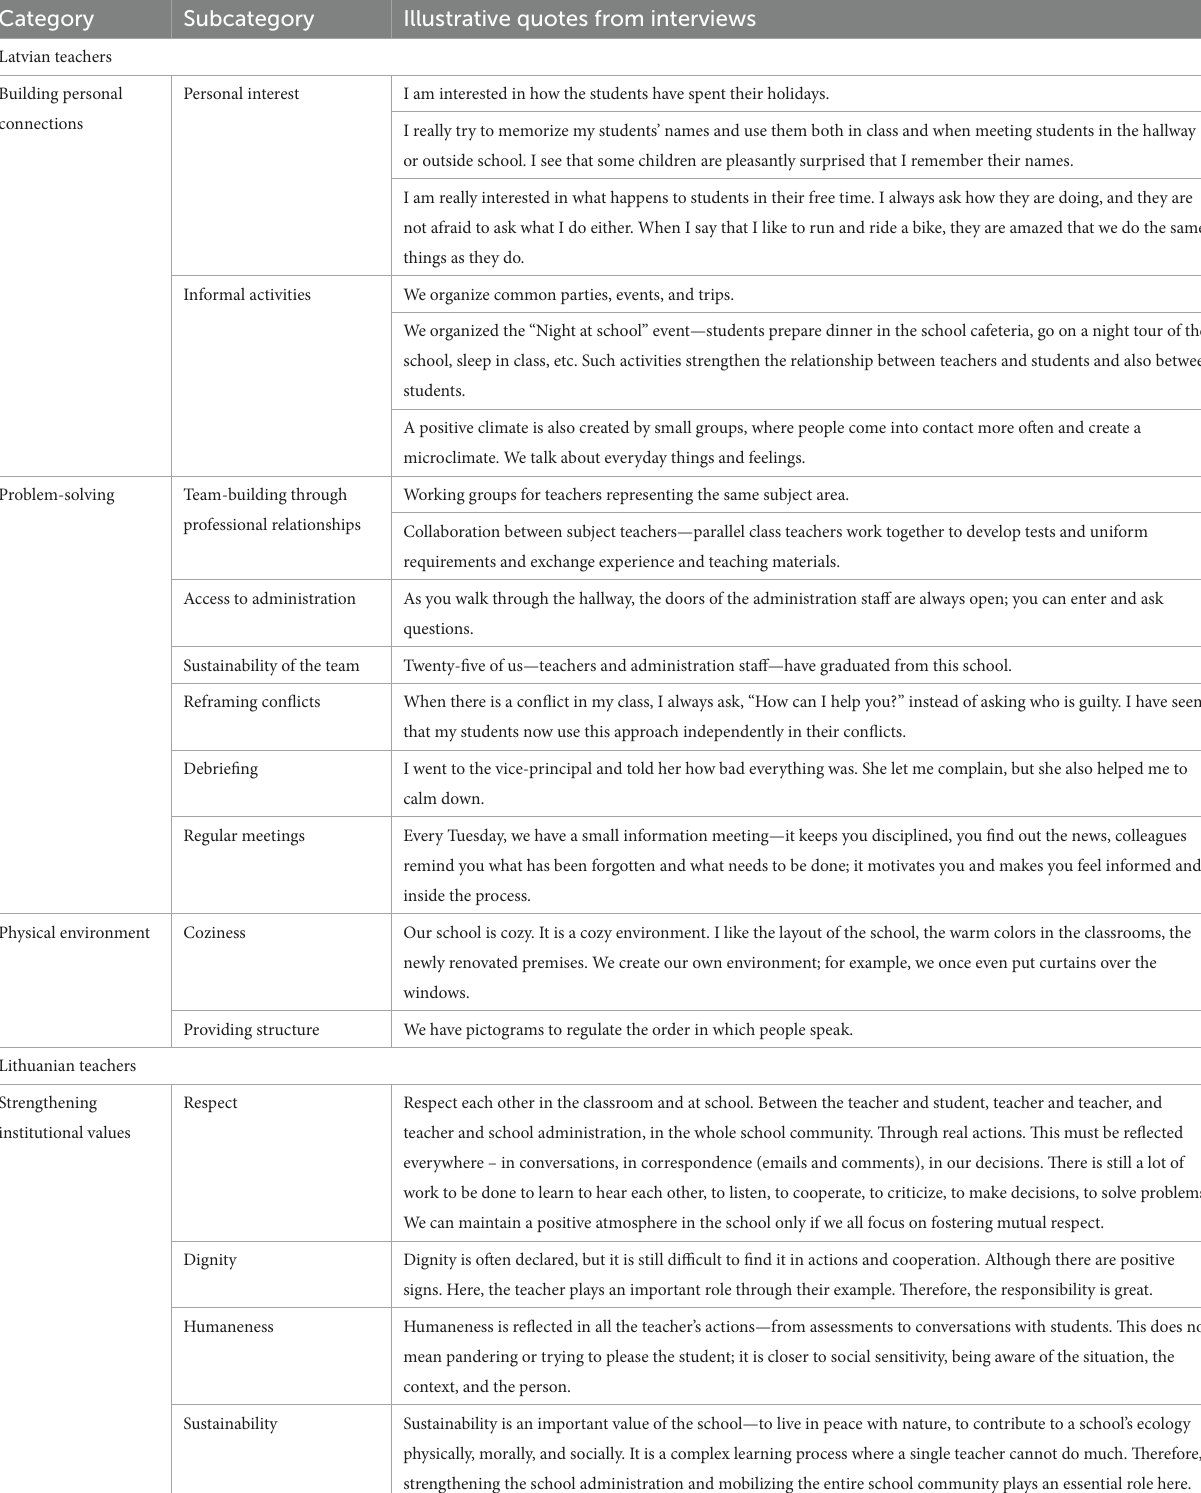
TABLE 2 Content of different categories in Latvian ( n = 83) and Lithuanian ( n = 69) teachers’ answers to the question “How do you contribute to a positive school climate?” Category Subcategory Illustrative quotes from interviews Latvian